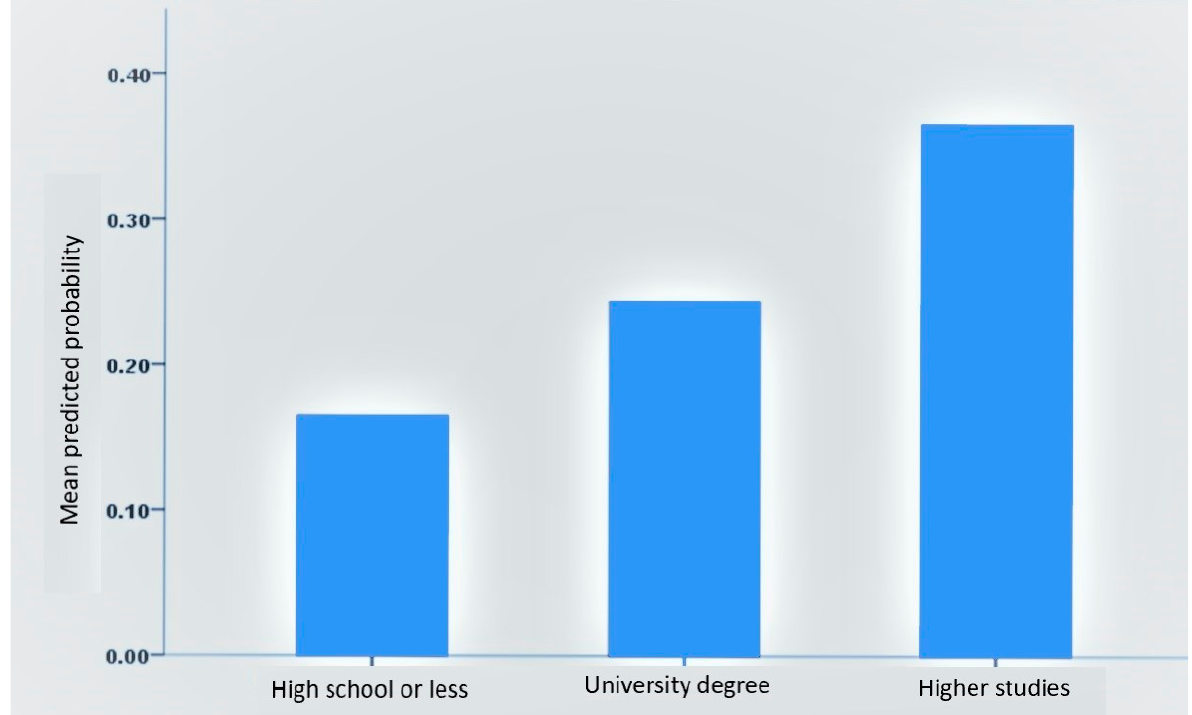
Figure A6. Mean predicted probability of parental agreement to send their children to school even if a COVID-19 outbreak happens inside the school in relation to their education level. Only parents with higher education level (Master or PhD) had significantly higher agreement (OR = 1.619, p = 0.014).